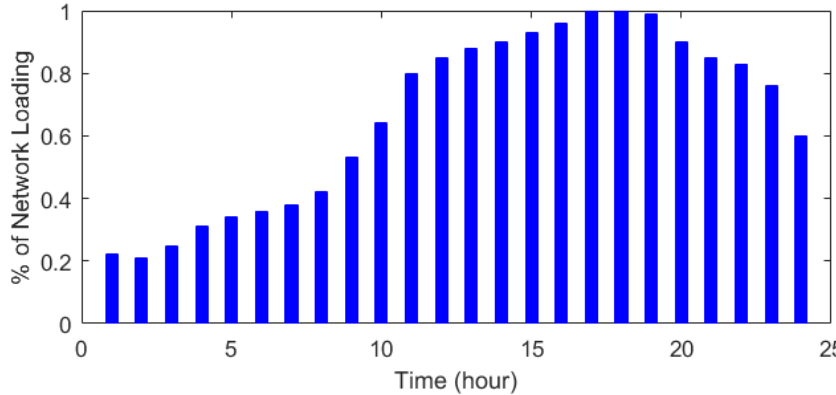
Figure 3. Network peak load percentage curve during 24 h.